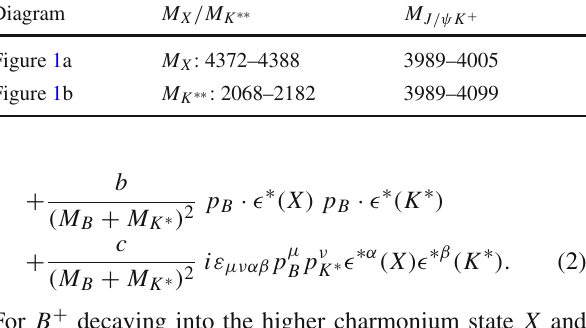
Table 1 TS kinematic region corresponding to the rescattering dia- grams in Fig. 1, in unit of MeV